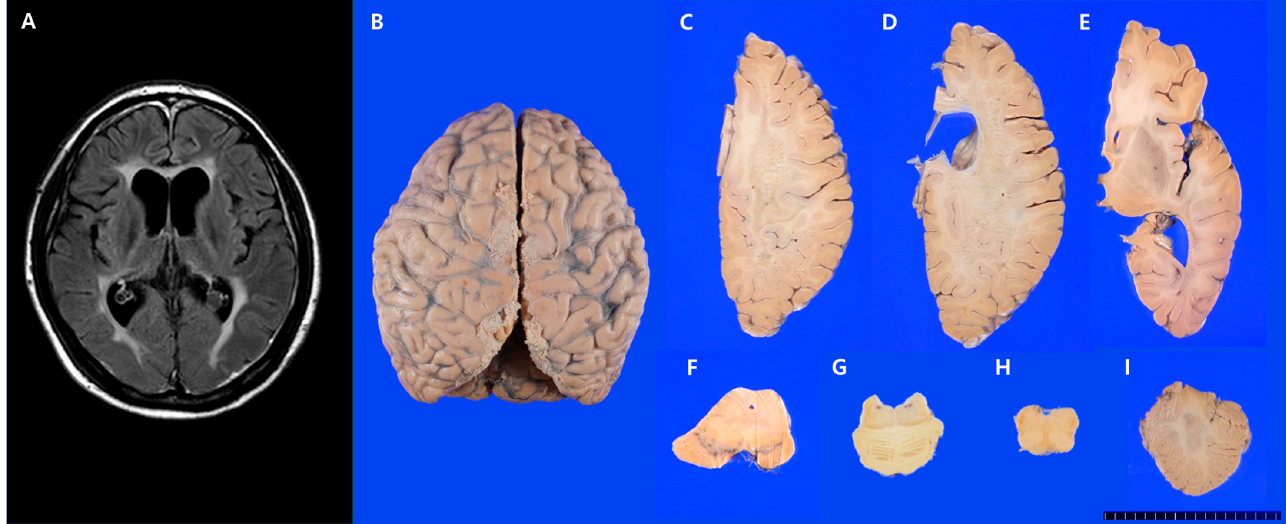
Figure 1. Brain magnetic resonance imaging (MRI) and gross findings of the brain in case 1. ( A ) Brain MRI (FLAIR sequence) revealed high-signal intensities in the bilateral periventricular white matter. ( B ) Mild gyral atrophy of the bilateral frontal and parietal lobes. ( C – E ) Horizontal sections of the right hemisphere revealed white matter degeneration of the frontal and parietal lobes, sparing of subcortical U-fibers, and severe corpus callosal atrophy. ( F – H ) There was symmetrical atrophy of the cerebral peduncle and pyramid and ( I ) a relatively preserved cerebellum.